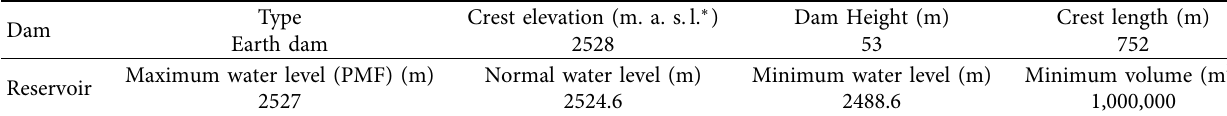
Table 1: General specifications of Sardab Dam.